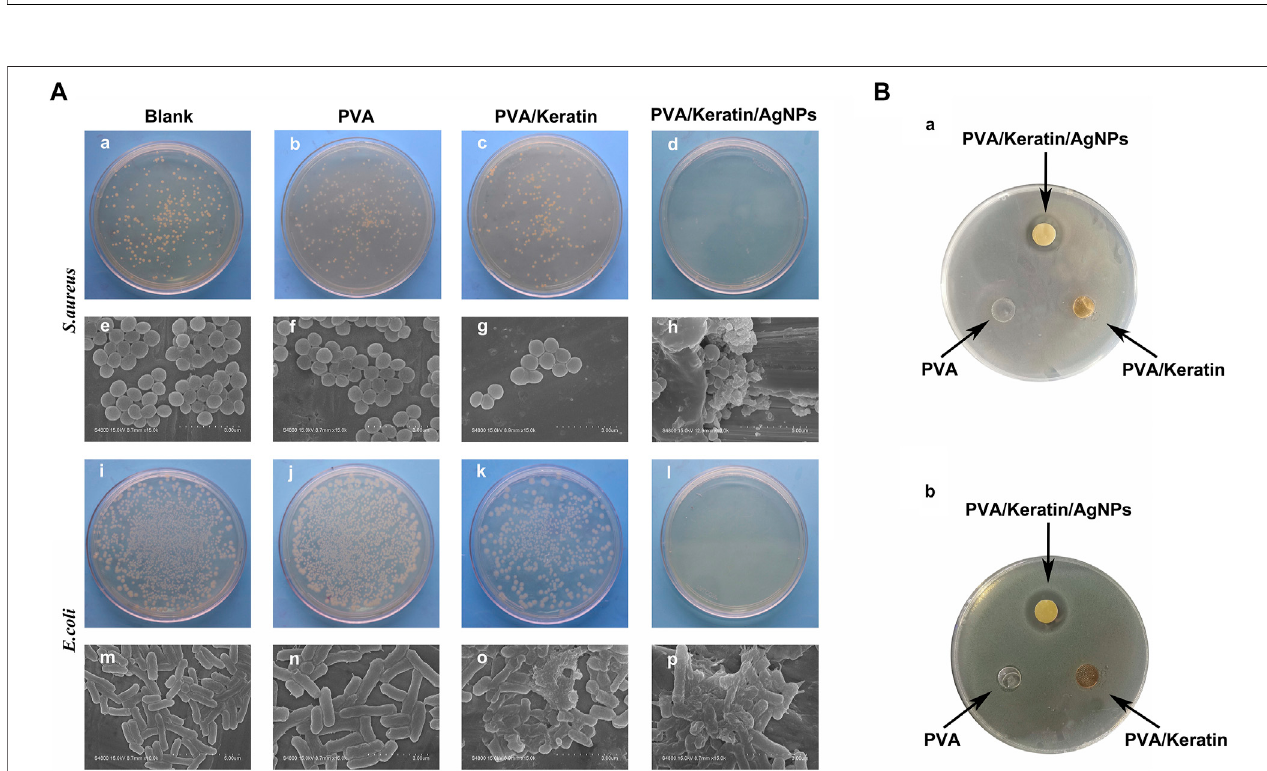
FIGURE4| HSMCsmorphologyandproliferationondifferentmaterials. (A) RhodaminestainingphotomicrographofHSMCs(bar (cid:1) 75 μ m). (B) Theopticaldensity within 1 week of culturing ( “ * ” represents p < 0.05).